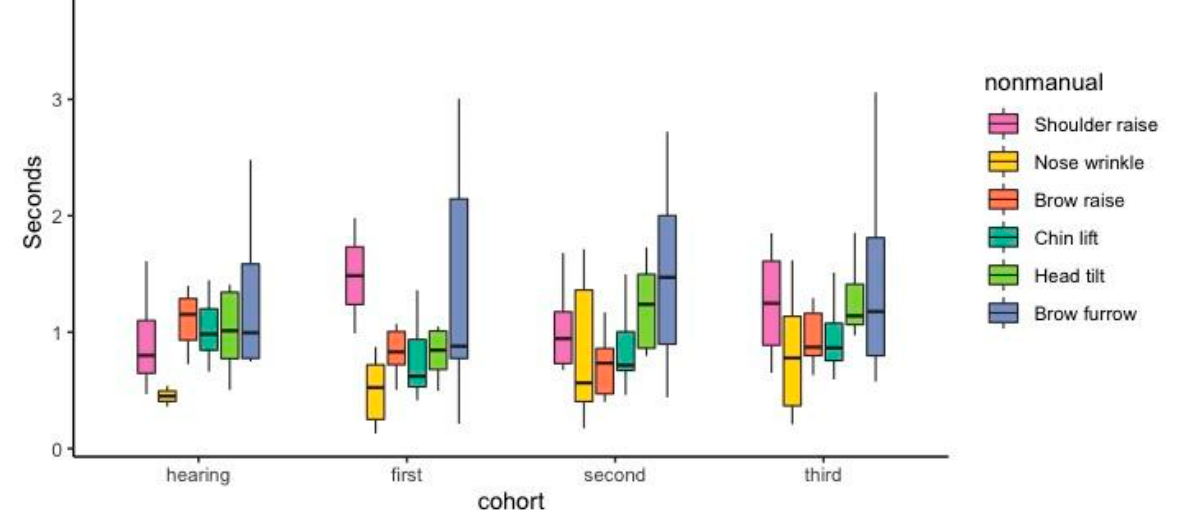
Figure 3. Average duration of each non-manual produced across cohorts. The black line shows me- dian duration for each non-manual. Whiskers represent maximum and minimum scores, excluding extreme outliers. Non-manual categories are ordered according to frequency, as represented in Fig- ure 2, with the more frequent to the right. Figure created using the ggplot2 package (Wickham 2016) in the R programming environment.